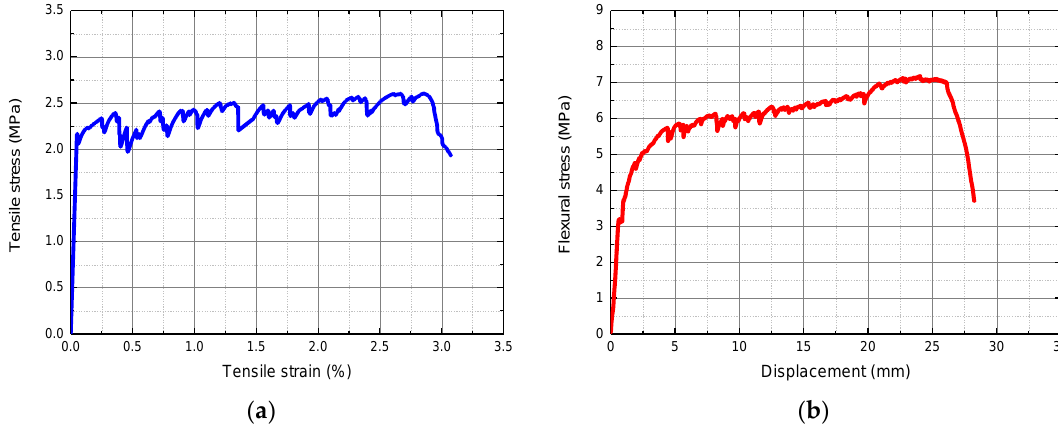
Figure 7. Typical load-displacement curves of engineered cementitious composite (ECC) under tension and bending: ( a ) Tension, ( b ) Bending.